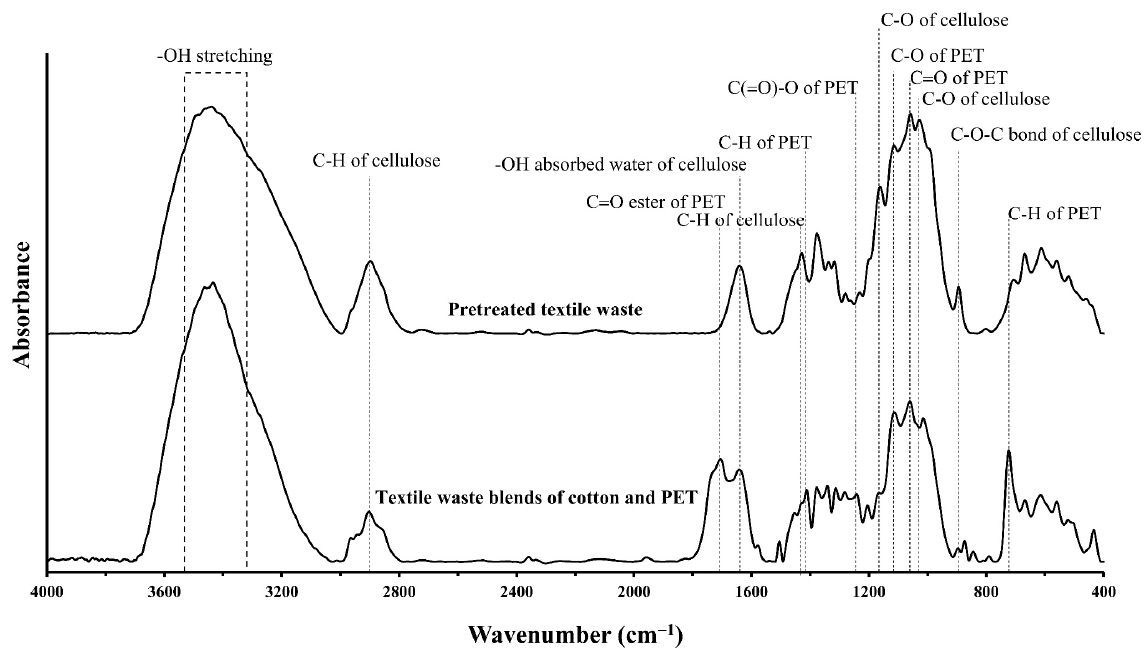
Figure 3. FTIR spectra of textile waste before and after pretreatment with 15% NaOH at 121 ◦ C for 15 min in the range of 4000–400 cm − 1 with resolution of 2 cm − 1 and 32 scans. Table 1. Experimental design used in response surface methodology of two independent variables: enzyme loading ( X 1 ) and substrate loading ( X 2